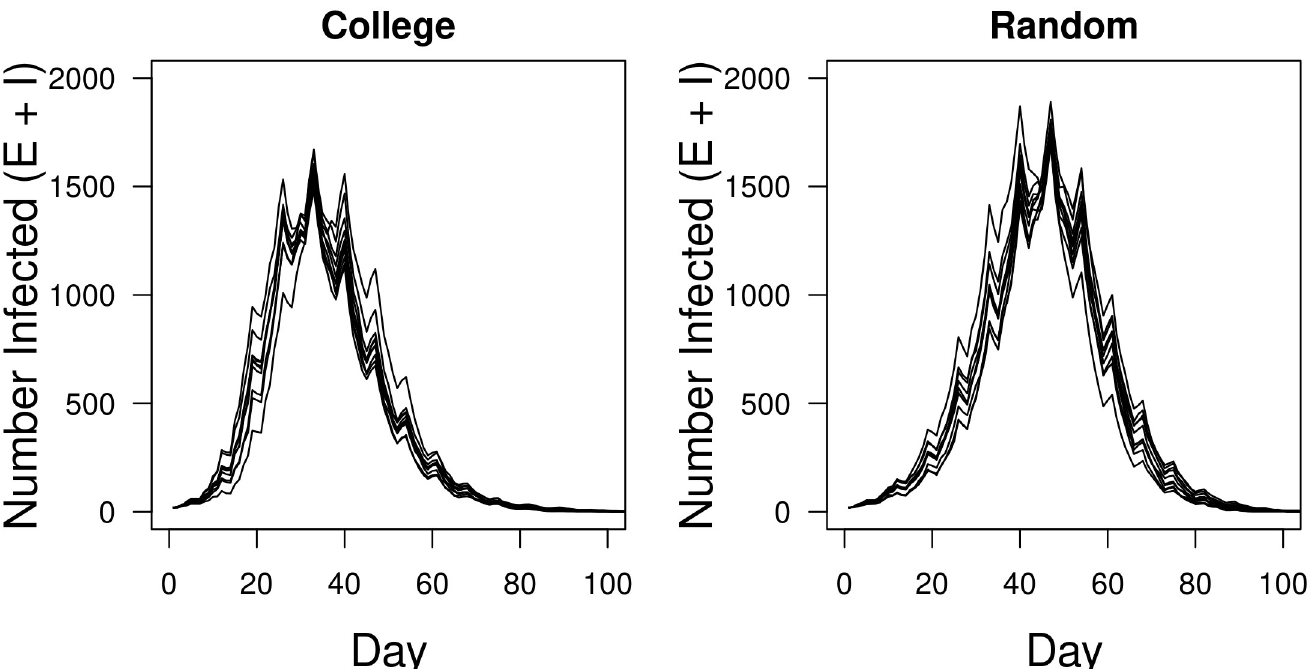
Fig 7. Time series dynamics of the simulation. The number of exposed (E) and infectious (I) individuals per day for ten replicate simulations on the college (left) and random (right) networks. Fewer individuals become infected on the college network than the random network because of the community structures (longer APLs and higher clustering coefficients) within majors. The weekly cycles are caused by the increased but sparser connectivity on weekends.